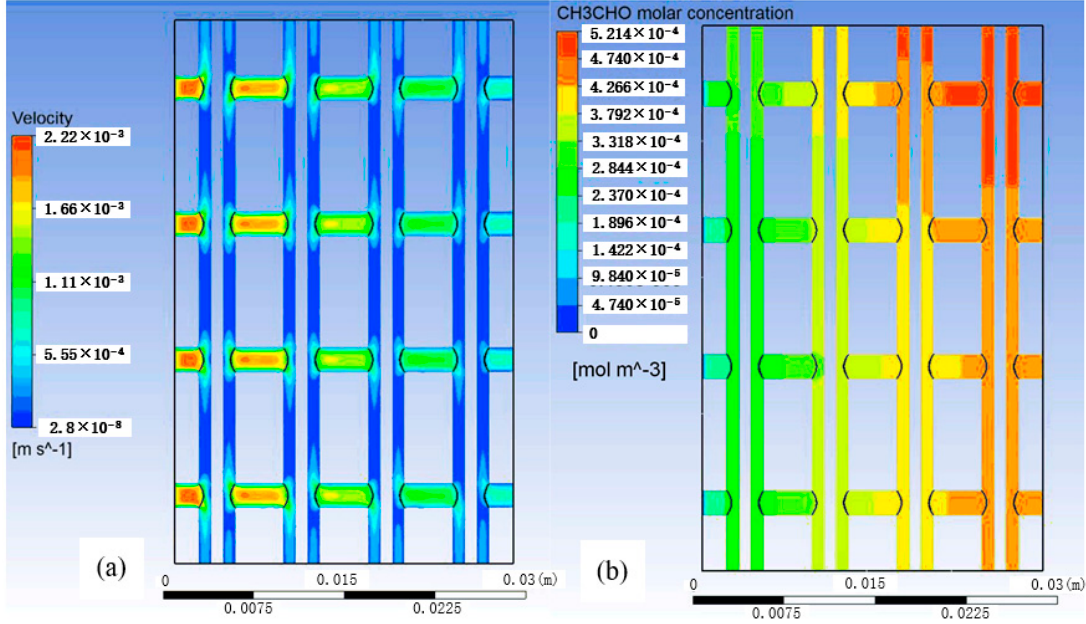
Figure 9. ( a ) The flow field and ( b ) CH 3 CHO concentration distribution on the cross-section x = 3.5 mm.